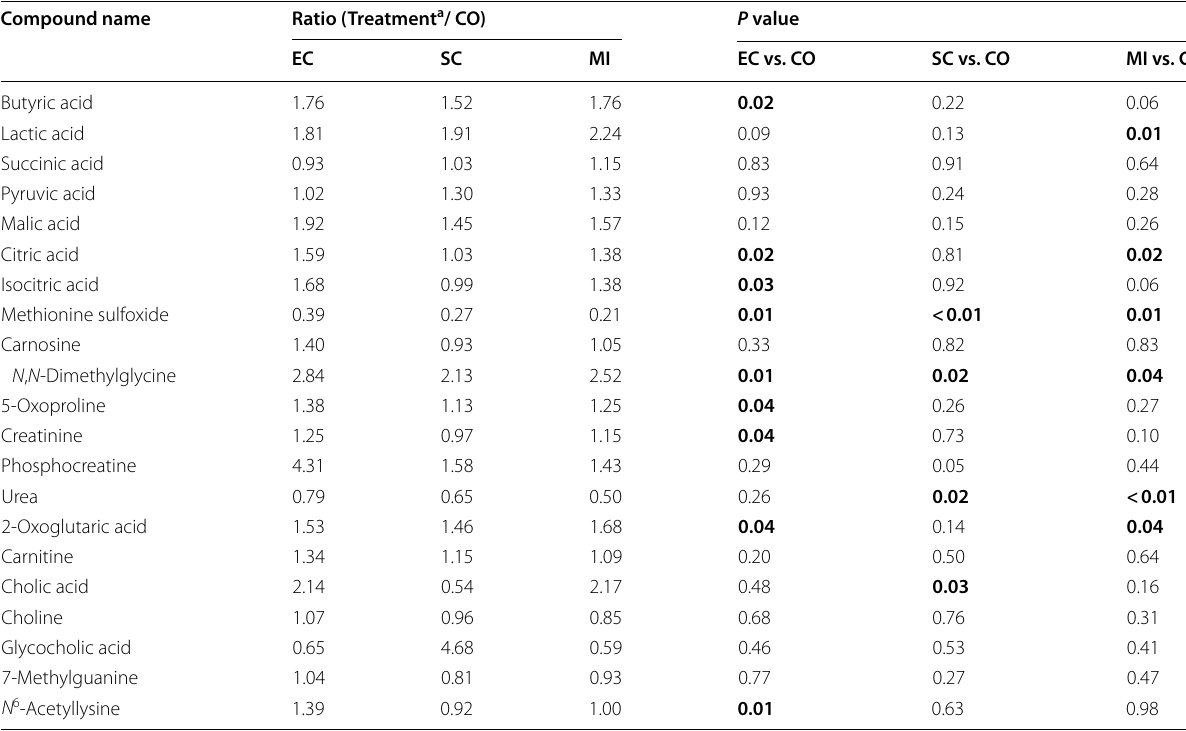
a CO (Control); basal diet only, EC; with EC12 (0.1%, w/w),SC; with SCE (1.0%, w/w), MI (Mix); with EC12 (0.005%, w/w) and SCE (0.25%,